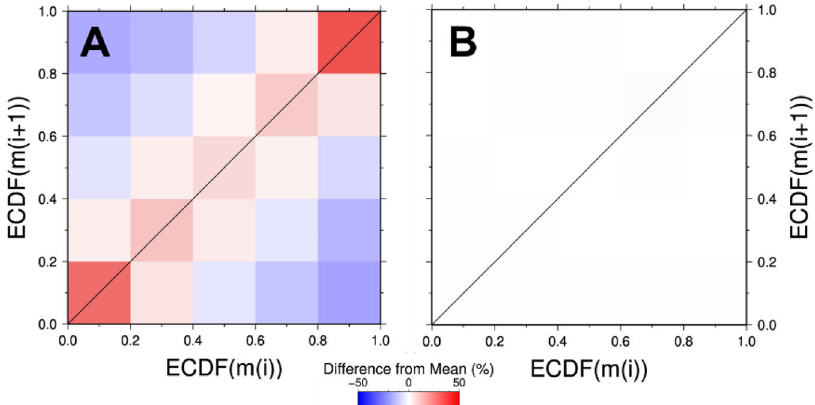
Fig. 2 | Empirical cumulative density function (ECDF) value of an event mag- nitude(m(i))comparedtothatofthesubsequent event(m(i+1)). Comparisons arefor A thereal, fi lteredsouthernCaliforniacatalogand B thiscatalograndomized by event time. Color scale shows the number of event comparisons that fall into